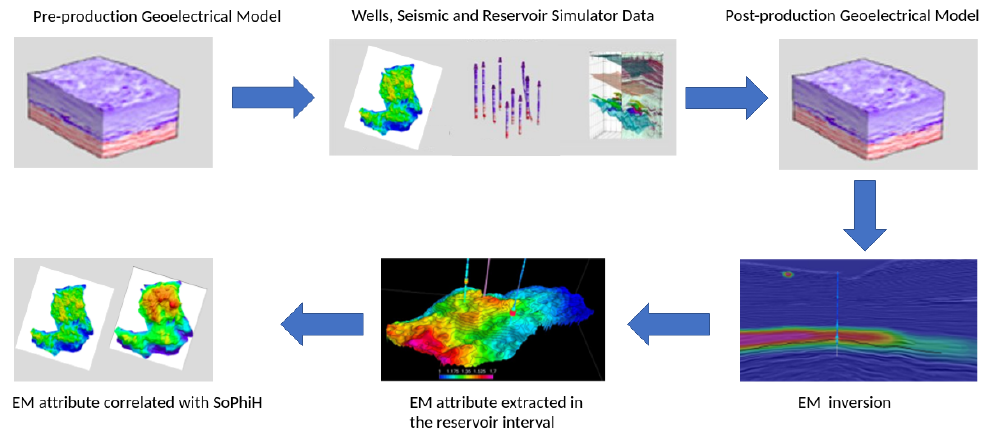
Figure 2. Flowchart representation of the CSEM time-lapse monitoring